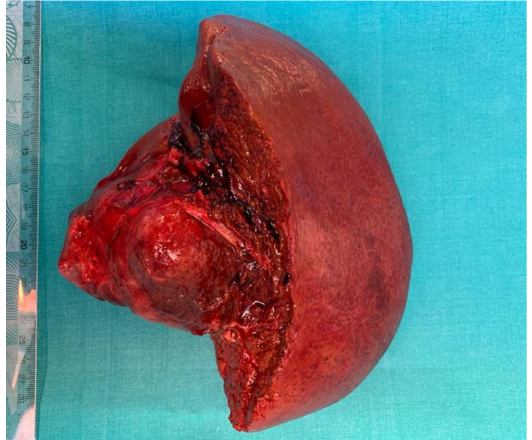
Figure 5. The specimen of right hepatectomy extended to the caudate lobe and to inferior cava vein with a total weight of 1100 g, measuring 22/16/10